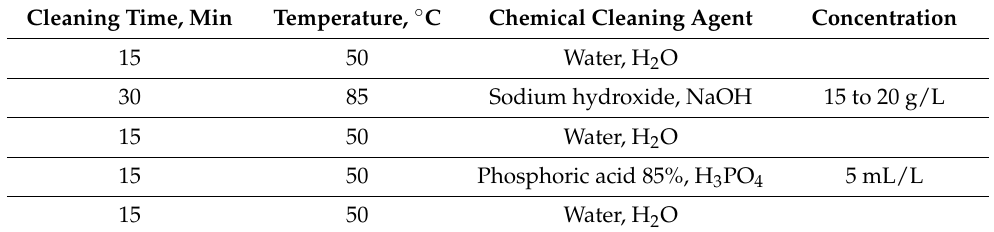
Figure A2. Permeability test at the end of each filtration process for feed of 200 ppm. Table A1. Ceramic membrane cleaning cycle required by the